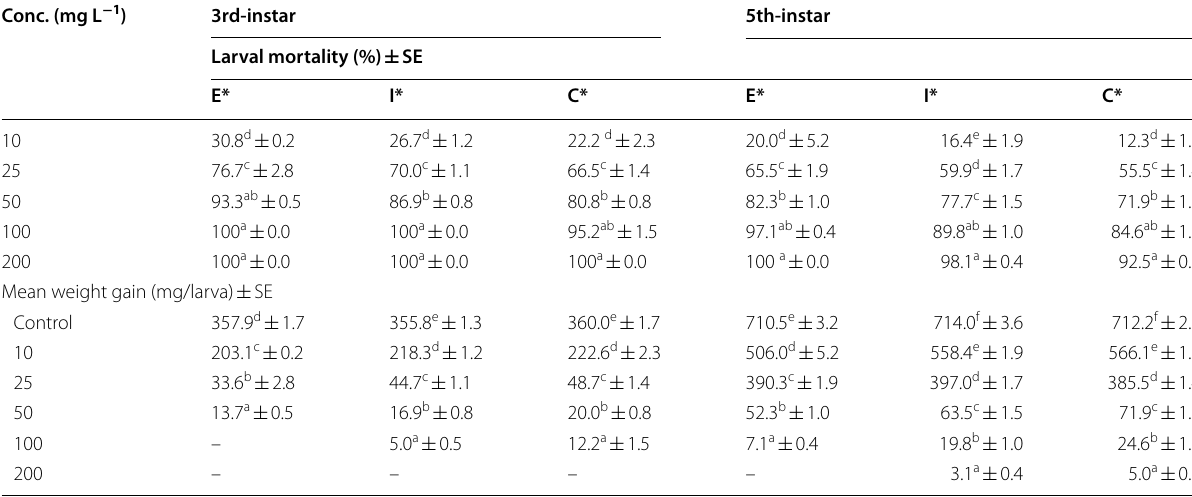
Means followed by the same letter in the same column are not significantly different according to Tukey’s multiple range test at P < 0.05 E*: Emamectin benzoate, I*: Indoxacarb, C*: Chlorantraniliprole